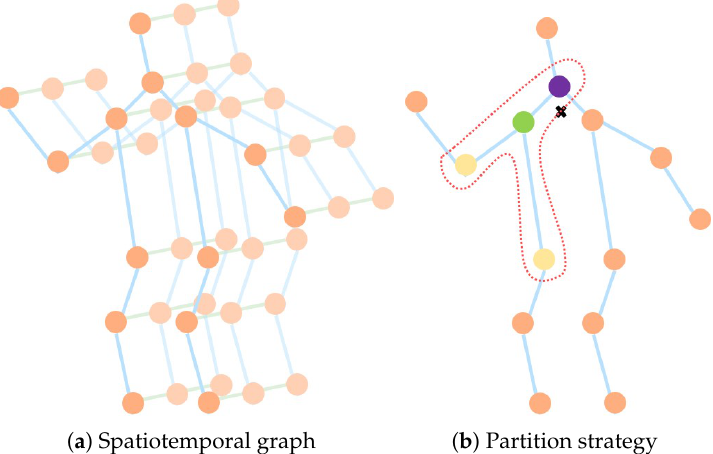
Figure 1. ( a ). The spatiotemporal graph modeled by input skeleton sequence used in ST-GCN. ( b ). The partition strategy of the neighboring joints in